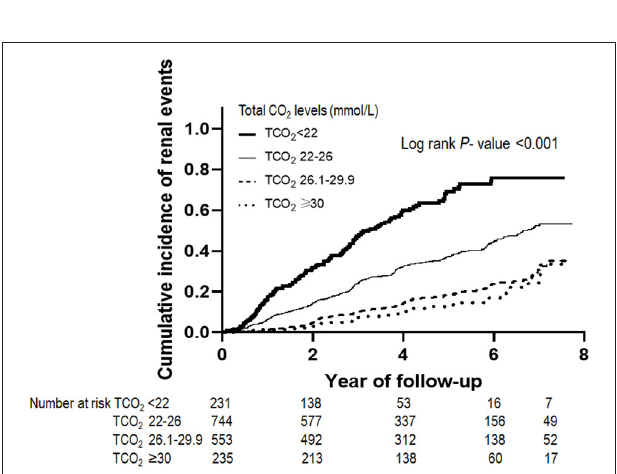
FIGURE 3 | Renal events according to serum bicarbonate groups. The Kaplan–Meier curves show that the low TCO 2 group had a significantly higher cumulative incidence of renal events ( P < 0.001). TCO 2 , total carbon